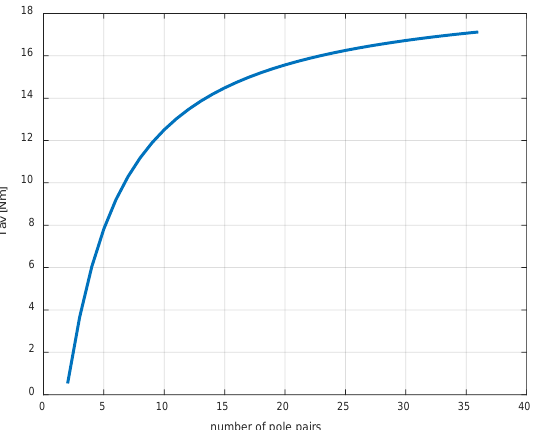
Figure 10. The average value of the torque of one CM segment as a function of the number of pole pairs.